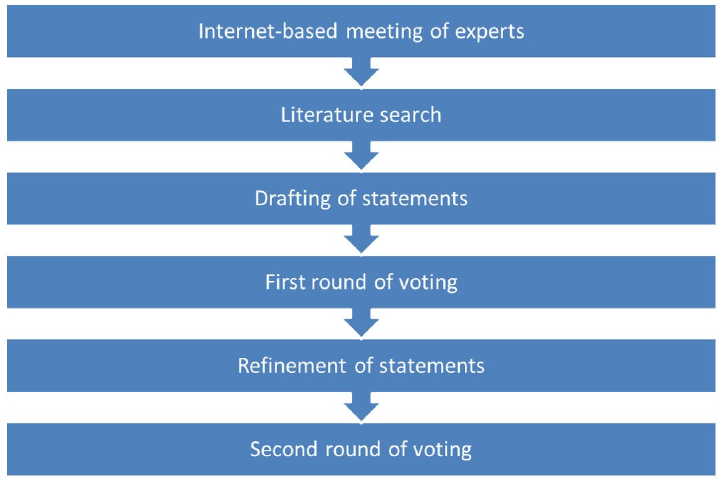
Figure 1. Overview of Delphi process